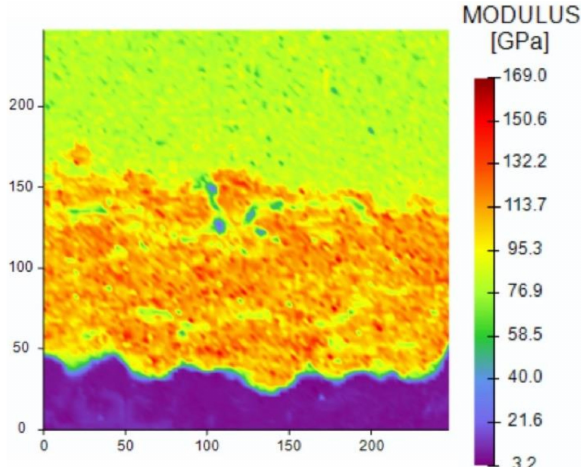
Figure 24. Modulus of elasticity countor plot. The mostly green region is the Al substrate material, the orange / yellow / red region is the Cu cold spray coating, and the purple region is the mounting resin.